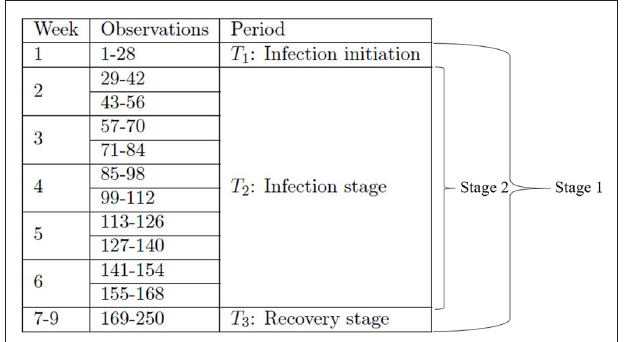
FIGURE 2 | Time segments for the first- and second-stage